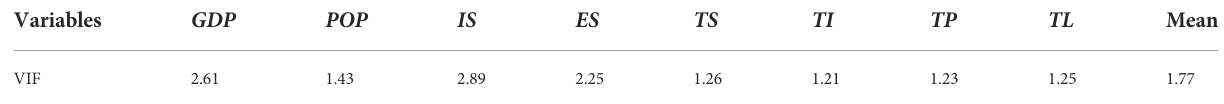
TABLE 2 Results of the multicollinearity